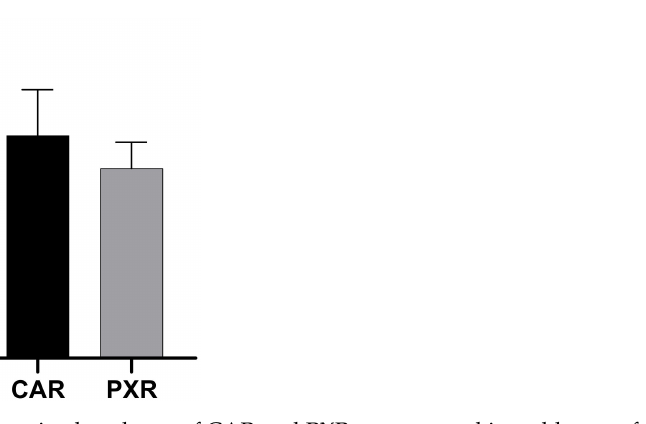
Figure 4. Protein abundance of CAR and PXR as measured in stably transfected MDCK-CAR and MDCKII-PXR cells. Data given as mean ±